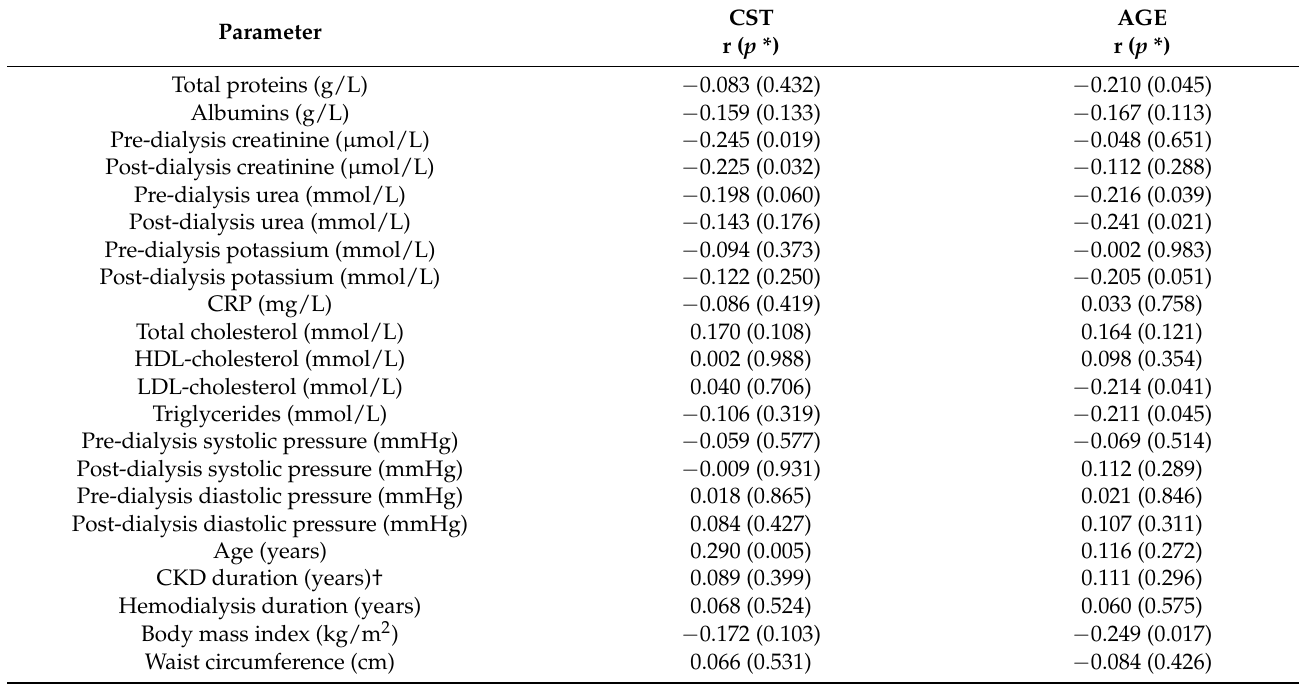
Table 3. Correlation of CST and AGE levels in hemodialysis patients between selected anthropometric, laboratory and clinical parameters (N = 91).